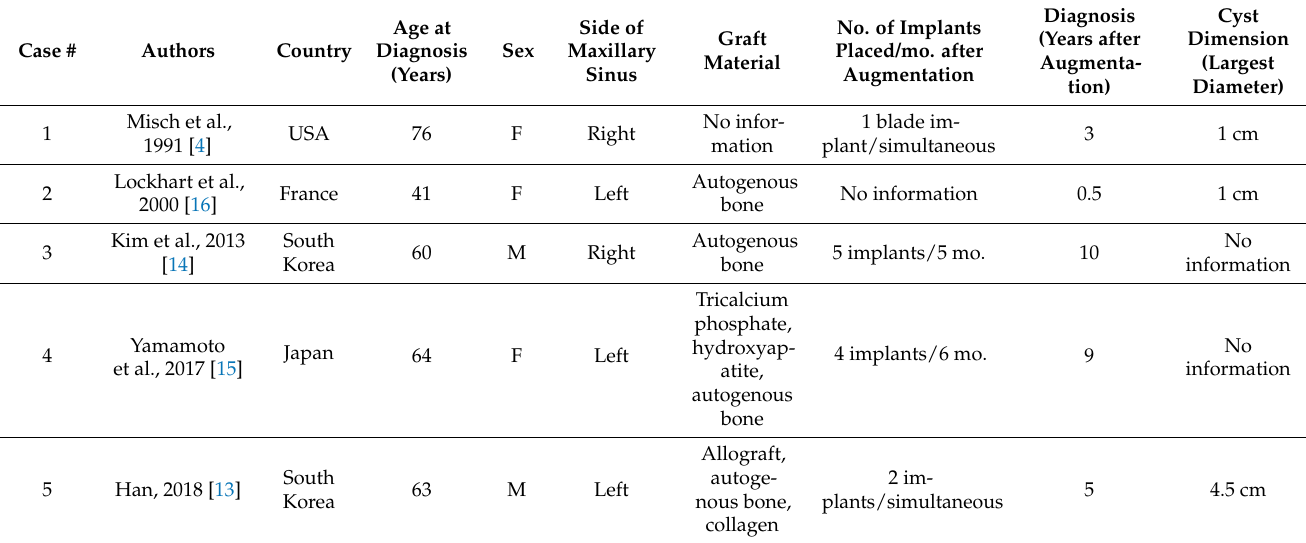
Table 2. Compilation of cases of SuCC from the literature